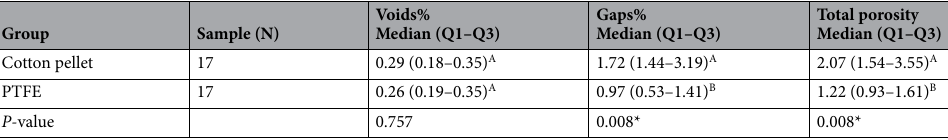
Table 1. Medians and interquartile ranges (Q1-Q3) of the percentage volumes of voids and gaps and total porosity for the cotton pellet and PTFE groups. Different uppercase letters in the same columon indicate significant differences between the groups. * P < 0.05 by Wilcoxon signed-rank test. Q1, 25th percentile, Q3, 75th percentile.